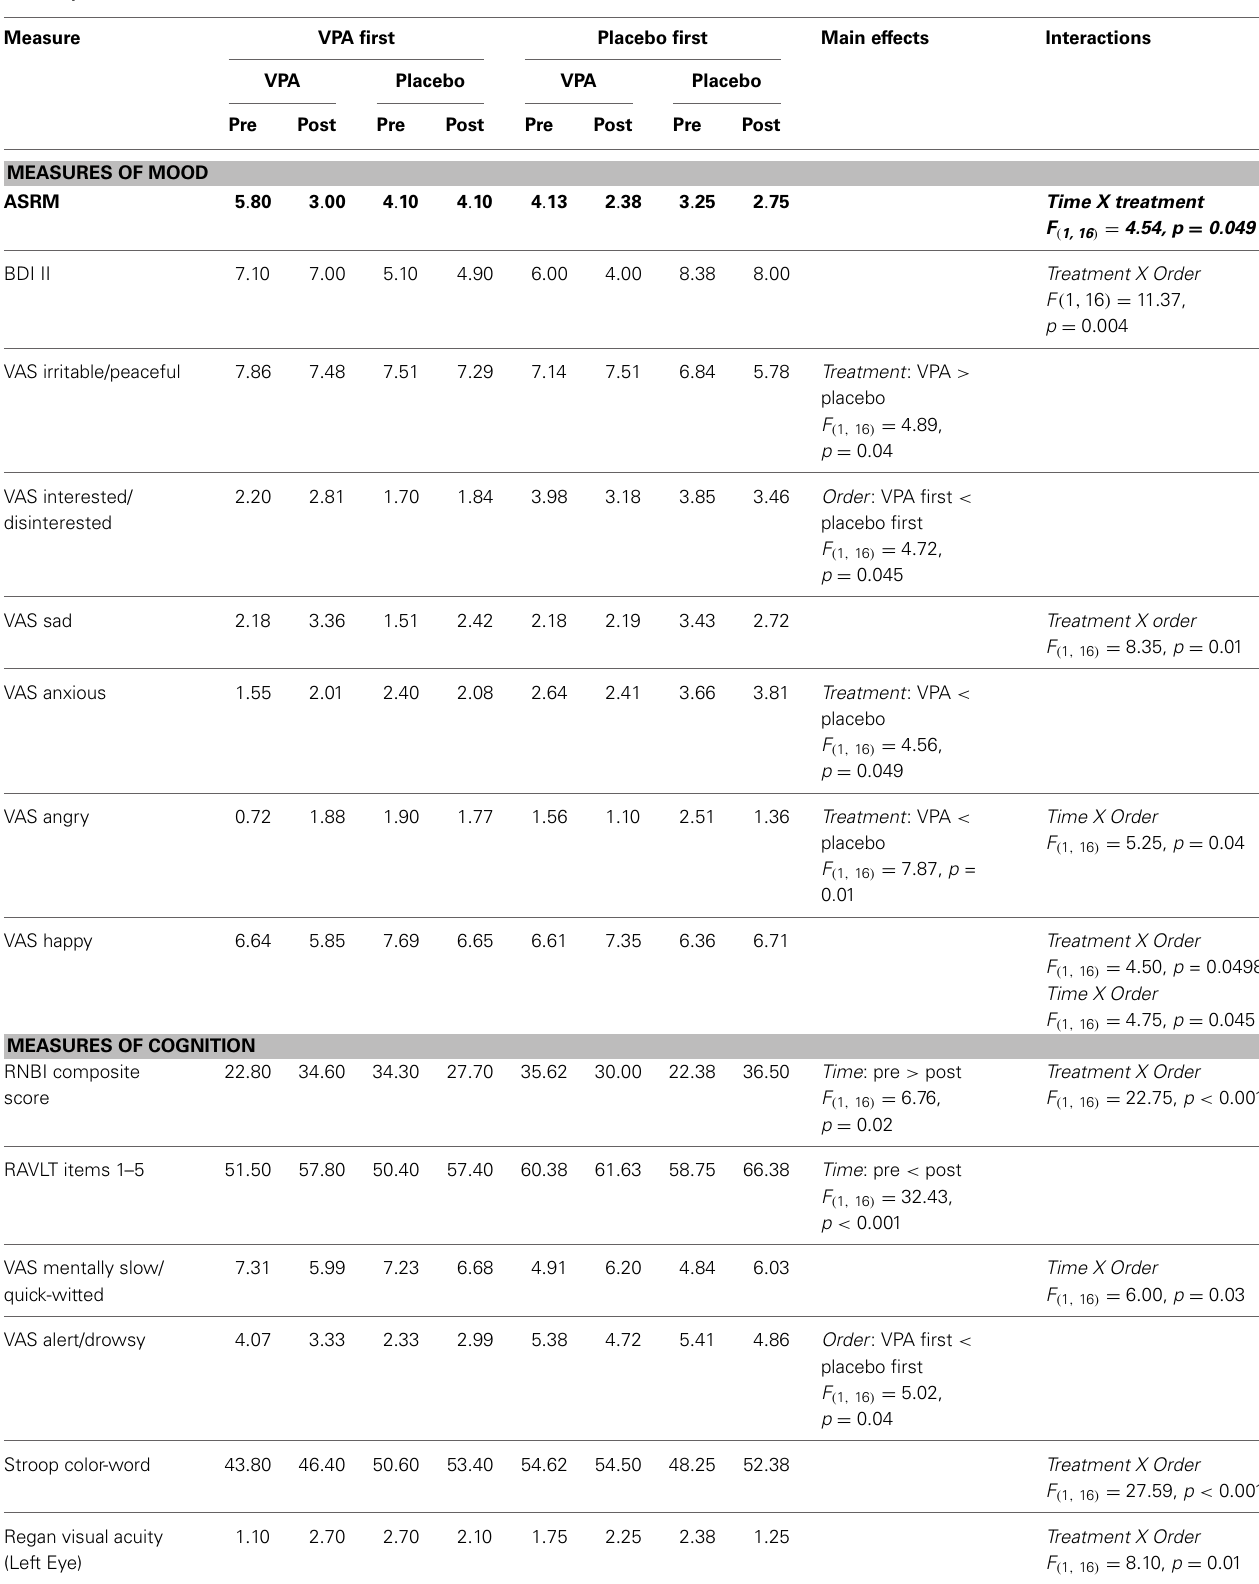
Table 3 | Analysis of mood and cognitive measures for crossover treatments. Measure VPA first Placebo first Main effects